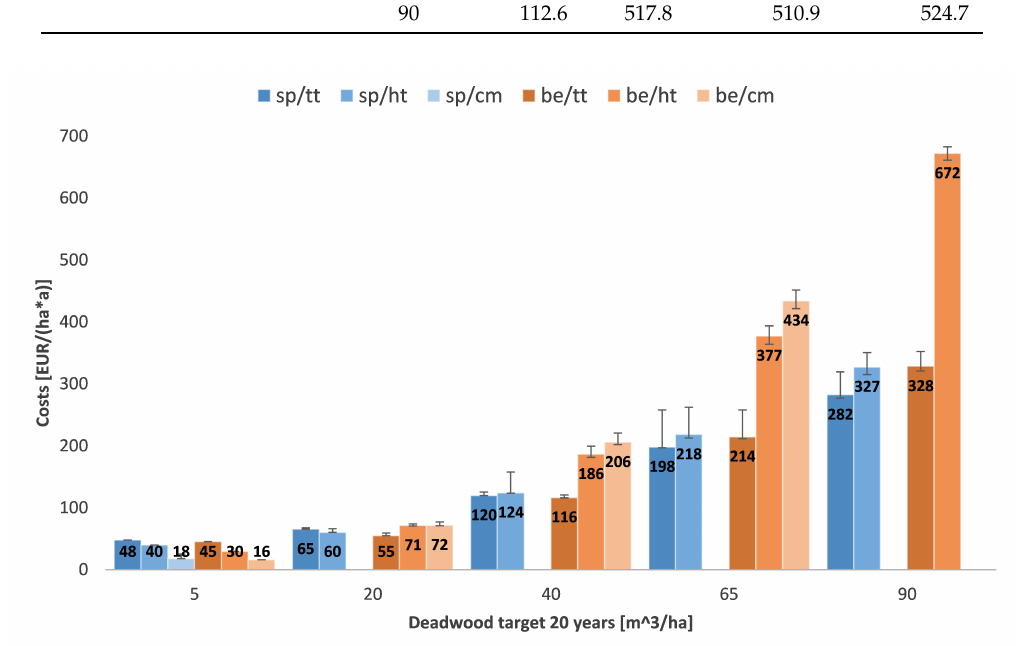
Figure 2. Forest enterprise “Eichelberg”: Costs in [ e ha − 1 a − 1 ] for target deadwood amounts in [m 3 ha − 1 ], to be maintained within 20 years. Blue columns show spruce ( sp ) and orange beech strategies ( be ). tt : Total tree, ht : Heavy timber, cm : Crown